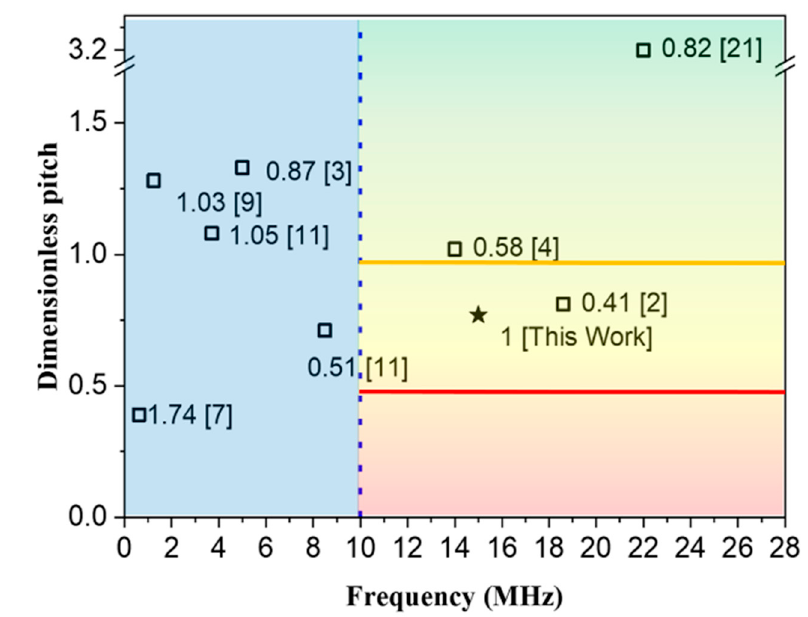
Figure 8. Comparison of working frequency, pitch, and bandwidth of different types of PMUTs under fluid load. The values in the label are the bandwidths (from references) normalized to our study. The hollow square represent the results in the published literature, and the solid star represents the results given in this study.